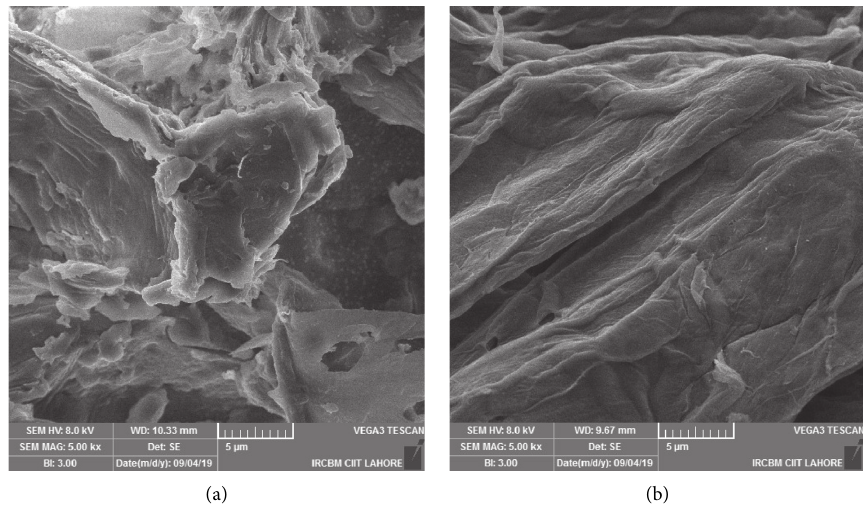
Figure 4: SEM image of (a) cellulose after DWS